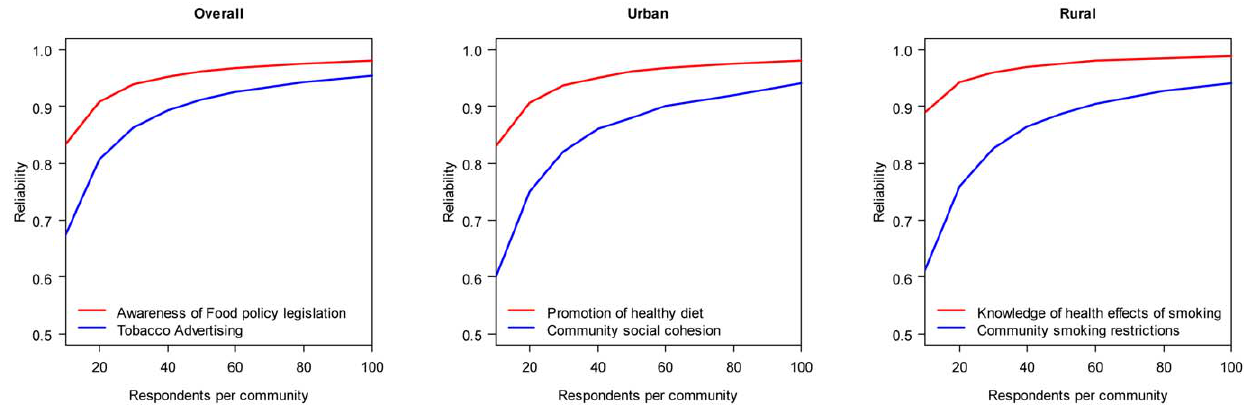
Figure 1. Association between sample size of respondents per community and reliabilities of community-level measures derived from EPOCH 2, overall and in urban and rural communities. In each panel, the measures with the lowest and highest levels of interrater agreement are plotted; all other measures will lie between these two curves. doi:10.1371/journal.pone.0044410.g001 PLOS ONE |